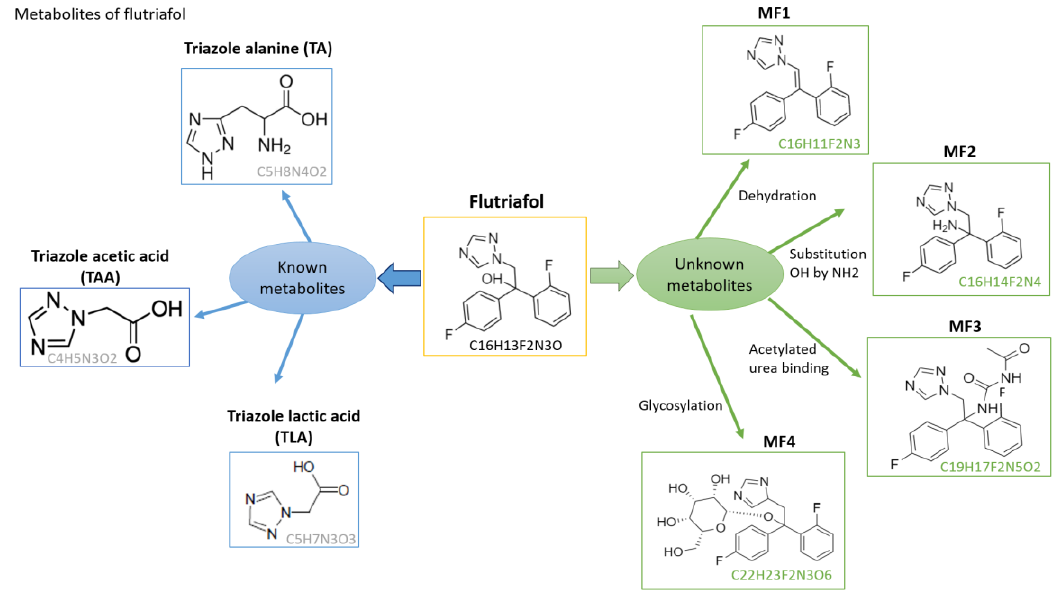
Figure 3. Metabolites of flutriafol identified by suspect screening and unknown analysis.